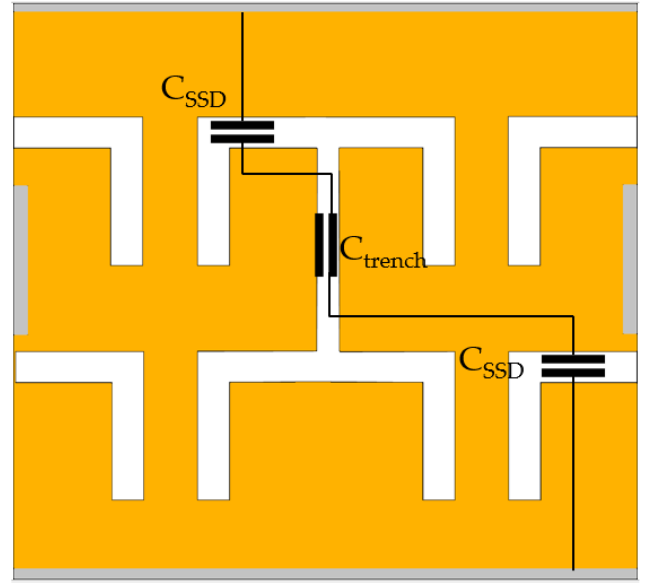
Figure 11. Capacitance estimation of SSDBR.